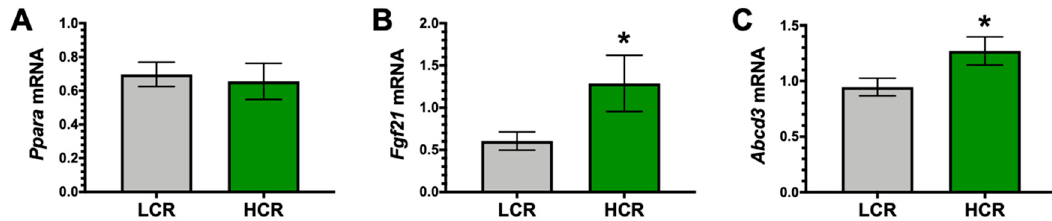
Figure 4. Hepatic peroxisome proliferator-activated receptor- α (PPAR α ) and target genes in LCR and HCR rats. ( A) Hepatic PPAR α ( Ppara ) mRNA levels. ( B ) Hepatic fibroblast growth factor-21 ( Fgf21 ) mRNA levels. ( C ) Hepatic ATP Binding Cassette Subfamily D Member 3 ( Abcd3 ) mRNA levels. * p < 0.05 as compared to LCR rats. n = 9/group.